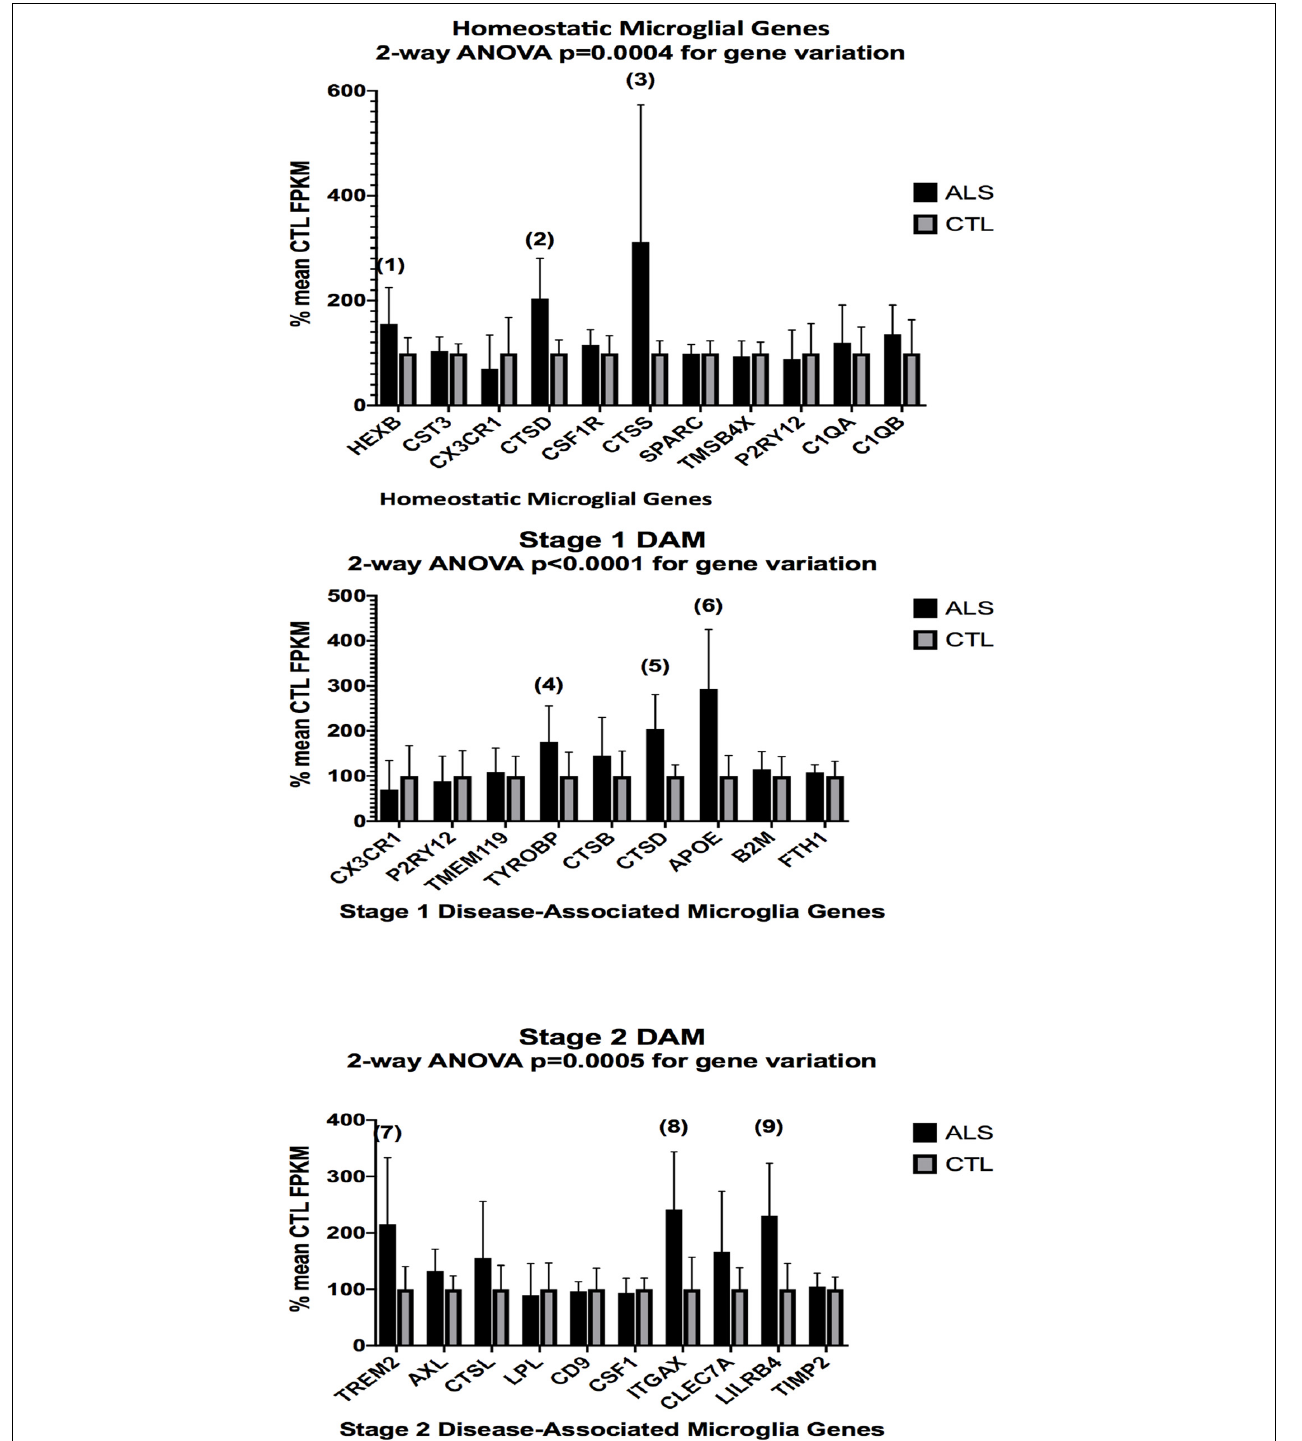
FIGURE 3 | Expression of genes associated with homeostatic microglia (top graph), Stage 1 DAM (middle graph), and Stage 2 DAM (bottom graph) according to Keren-Shaul et al. (2017) in ALS and CTL cervical spinal cord samples. Gene alignments were based on paired-end (PE) Illumina sequencing of rRNA-depleted tissue total RNA, followed by removal of sequencing adapters (Trimmomatic R (cid:13) ) and alignment against the hg38 version of the human genome using Tophat2/Bowtie2 and quantitation with Cufflinks. All samples with mean CTL FPKM < 2.0 were removed. Data are expressed as average ± SD of mean CTL gene expression. Two-way ANOVA results are shown in each graph. Unpaired t -tests for significance showed: (1), p = 0.055 (nearly significant); (2), p = 0.0032; (3) p = 0.040; (4), p = 0.046; (5), p = 0.0032; (6), p = 0.0018; (7), p = 0.021; (8), p = 0.0050; (9), p = 0.0038. n = 7 AlS and 8 CTL.